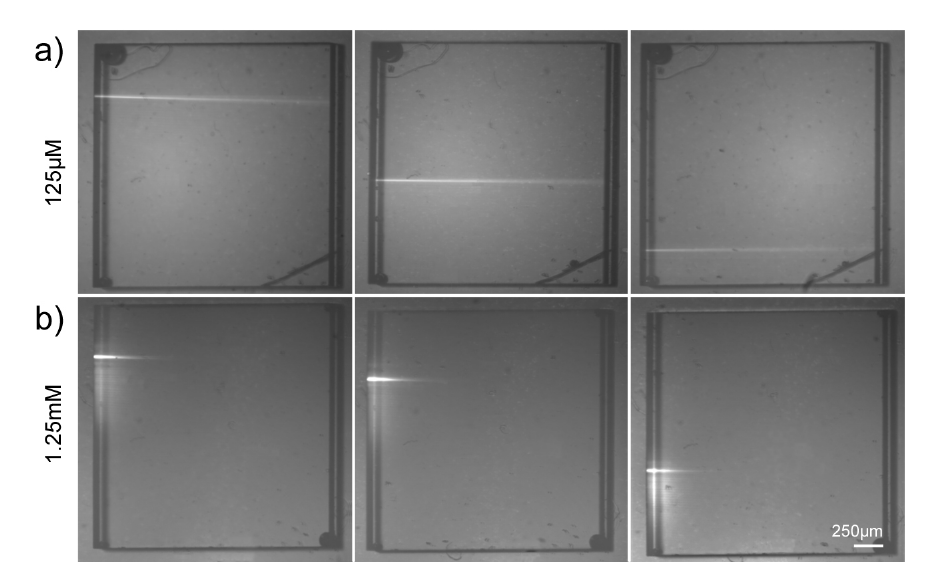
Figure 5. Excitation of a solution of Rhodamine 6G in methanol at two different concentrations : (a) 125 µM (b) 1.25 mM. Three optical waveguides on the left side of the chip are alternatively used. The scale bar is 250µm for all